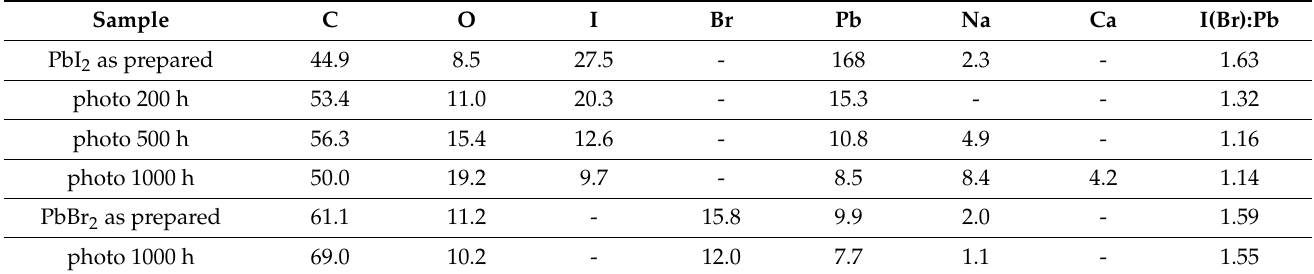
Figure 3. XPS survey spectra of PbI 2 and PbBr 2 halides after light-soaking. Table 1. Surface composition (in at.%).